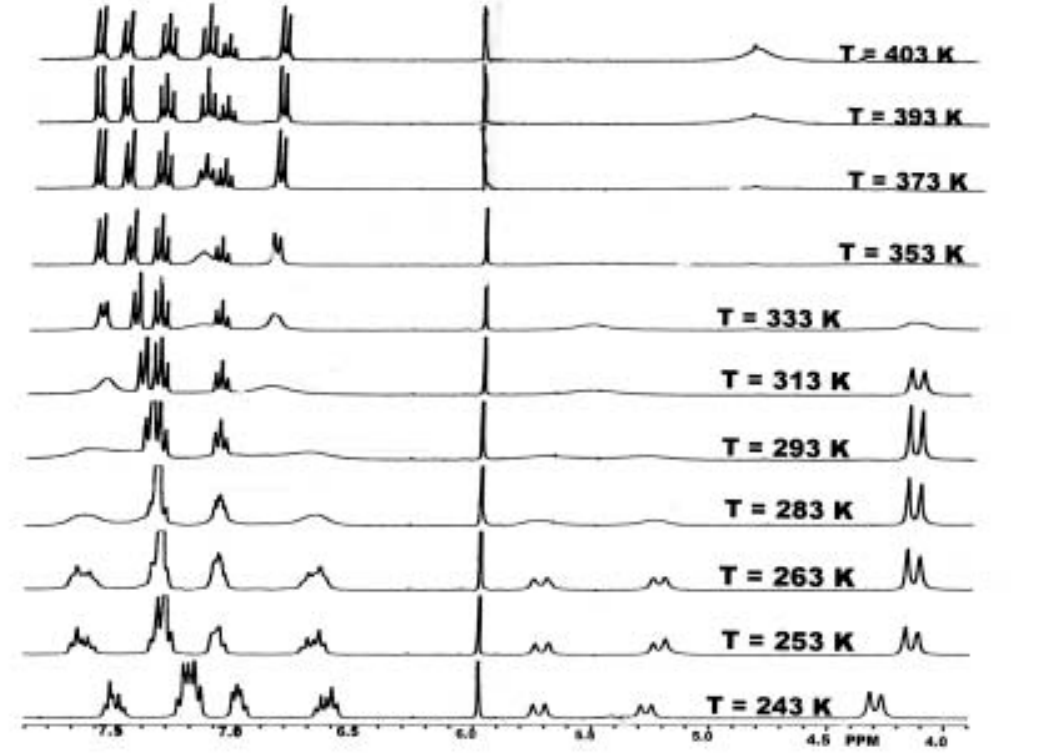
Figure 2. Variable Temperature (VT) 1 H-NMR spectra of CL